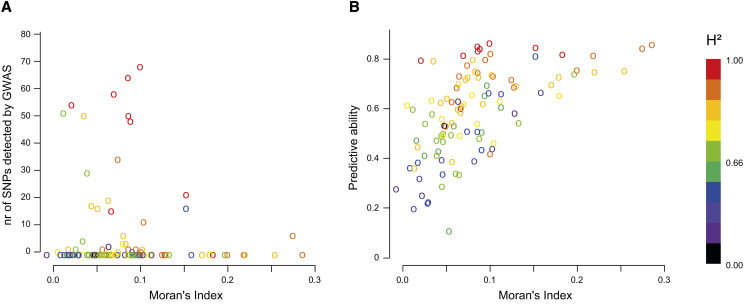
Scatterplot of Moran’s index and of (a) number of SNP markers detected by GWAS (q-value < 10%) and (b) observed predictive abilities of genomic prediction models for the different phenotypic traits analyzed in the study. Dots are colored according to the trait H2 (broad sense heritability like indicator).